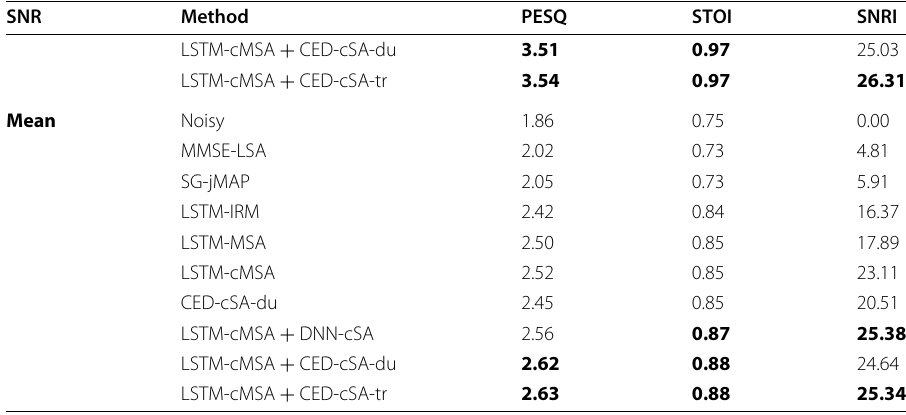
Table 1 Instrumental measures for baseline and proposed approaches averaged over seennoisetypes of the developmentset data. Note that the SNR conditions of − 5 and 15 dB are unseen during training, whereas the remaining SNRs have been seen. Best two approaches are in boldface (continued) SNR Method PESQ STOI SNRI LSTM-cMSA + CED-cSA-du 3.51 0.97 25.03 LSTM-cMSA + CED-cSA-tr 3.54 0.97 26.31 Mean Noisy 1.86 0.75 0.00 MMSE-LSA